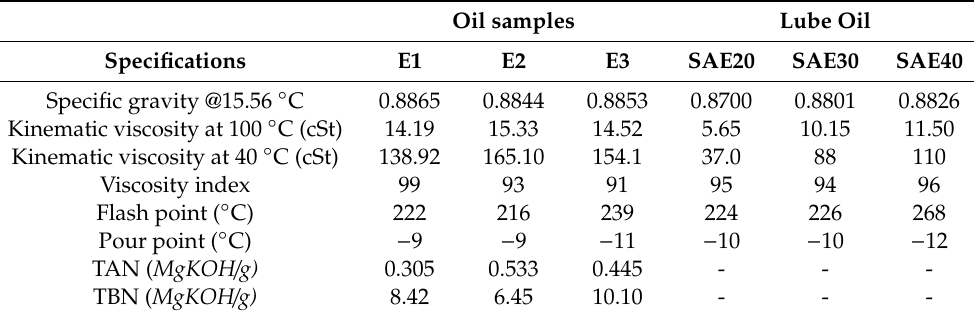
Table 3. Properties of the reclaimed base